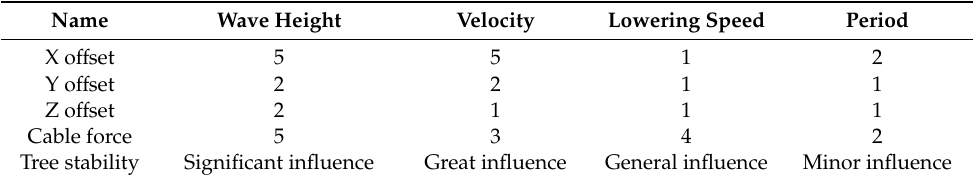
Table 7. The subsea tree sensitivity.